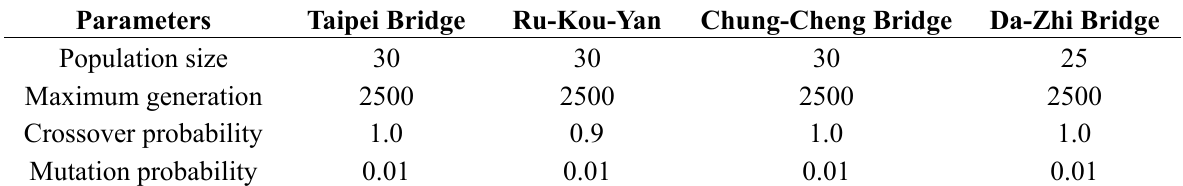
Table 4. The configuration of the GA.